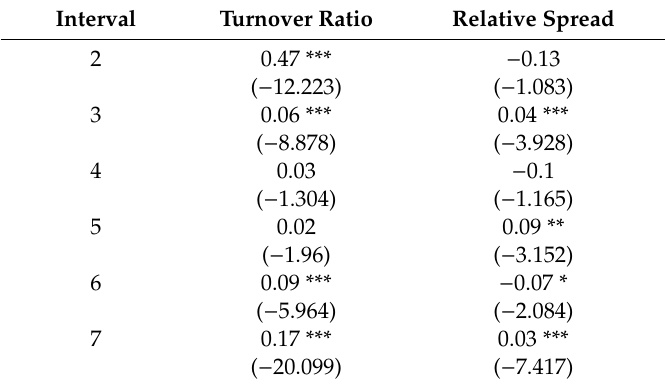
Table 3. Relation between Abnormal Returns and Liquidity Measurements. Interval Turnover Ratio Relative Spread 2 0.47 *** −